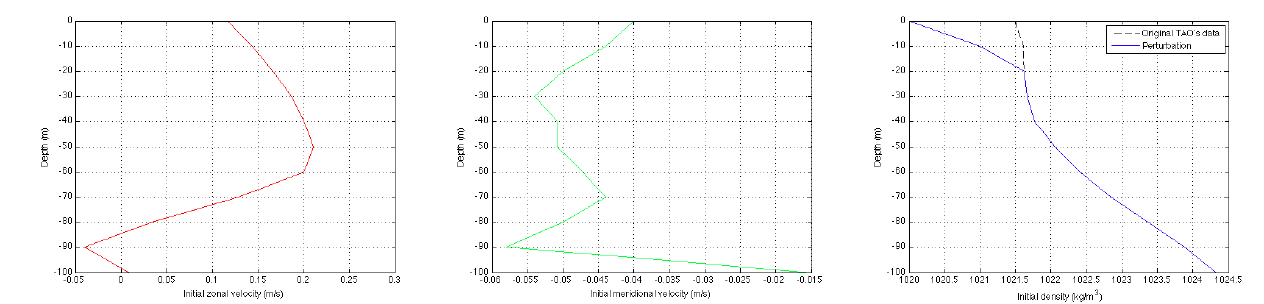
Fig. 2. Test 1: initial zonal velocity, meridional velocity and density profiles (from left to